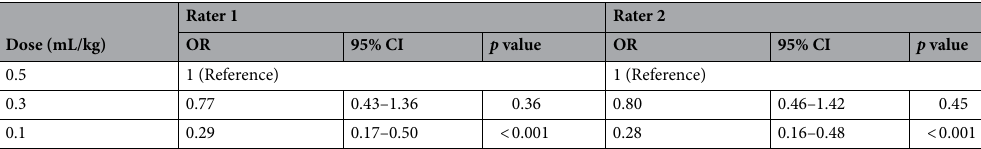
Table 2. Positive results in the S-test as determined by rater 1 and rater 2. CI, confidence interval; OR, odds ratio; S-test, precordial Doppler sound test.